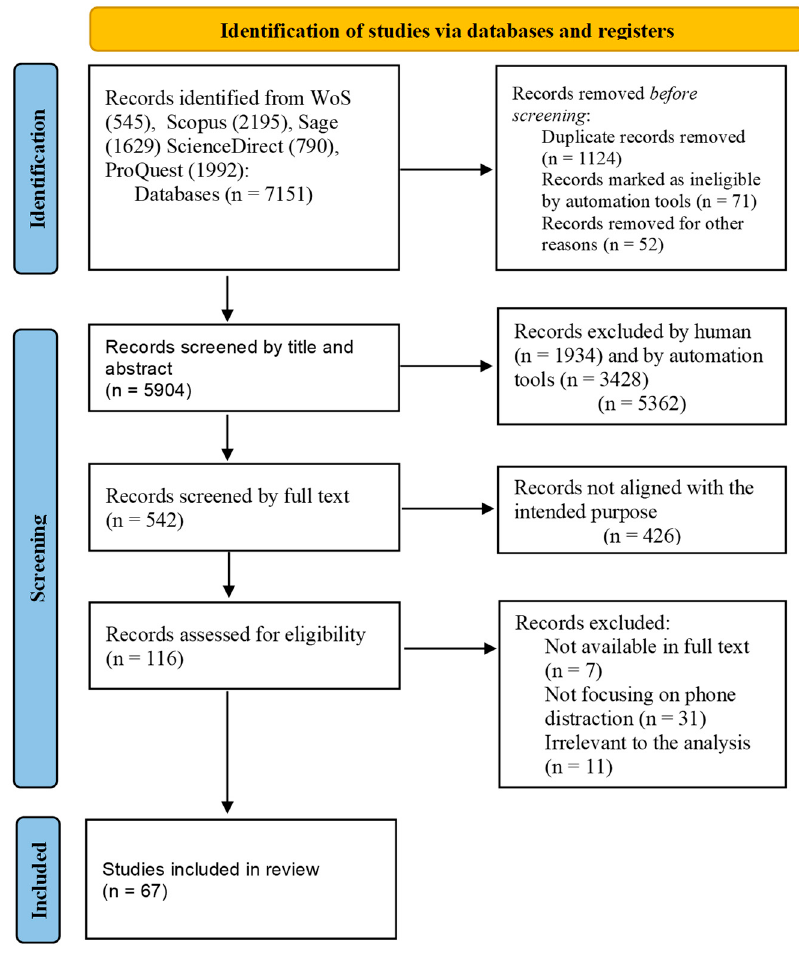
Figure 1. Study identification and selection based on the PRISMA-ScR flow diagram.